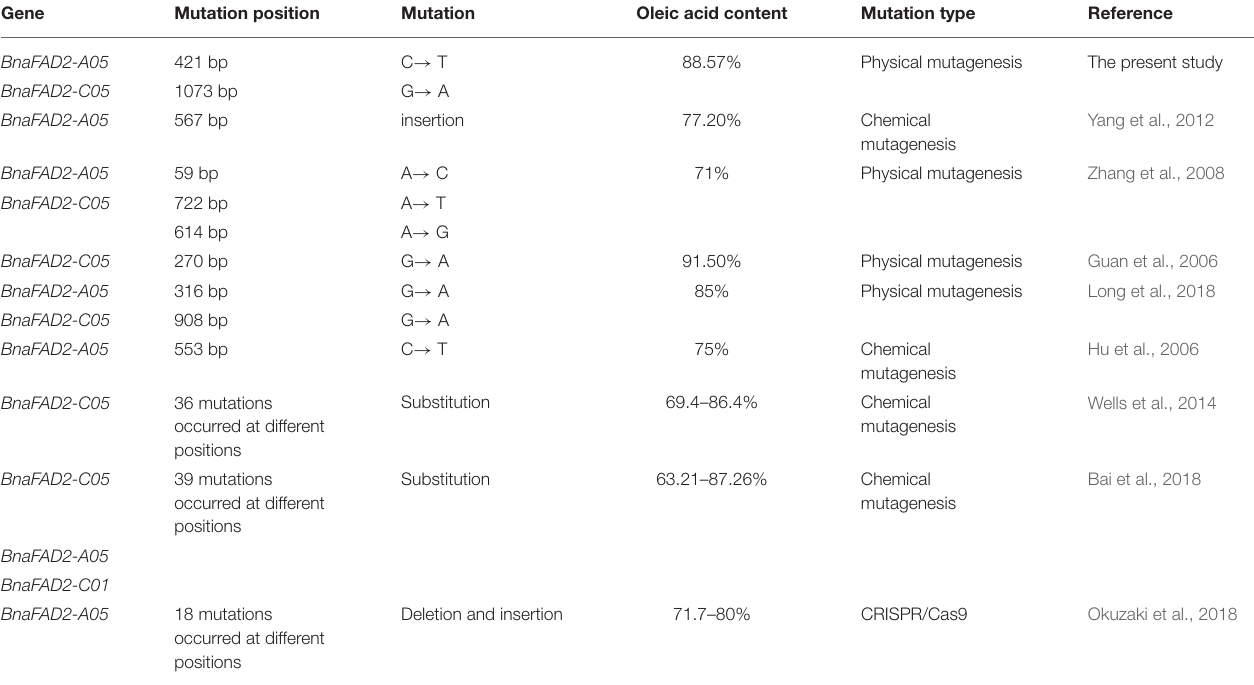
TABLE 2 | The mutation of BnFAD2 genes and corresponding oleic acid content in B. napus . Gene Mutation position Mutation Oleic acid